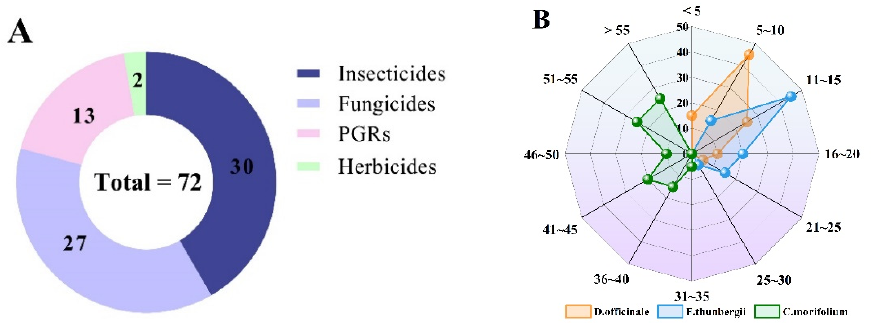
Figure 6. ( A ) Distribution of pesticide species tested in three TCM real samples. ( B ) Number of detectable residues in individual samples and the sample proportion.